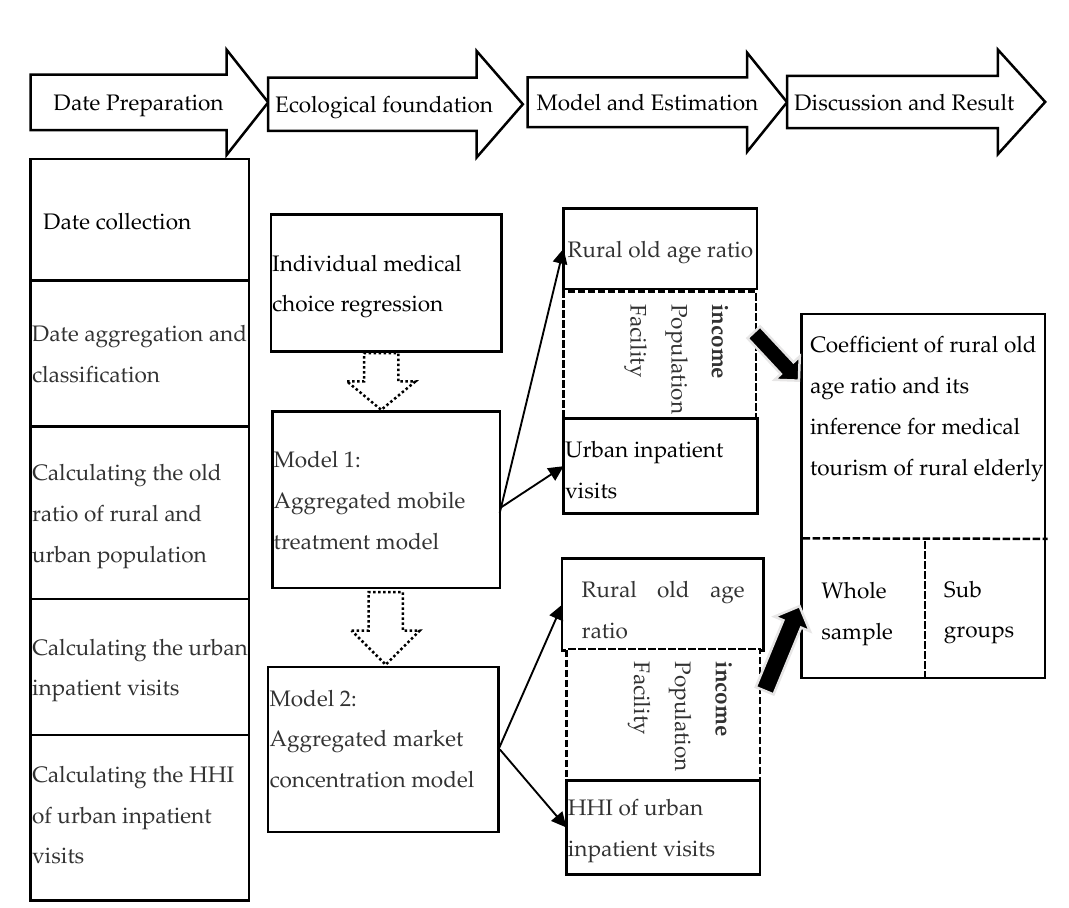
Figure 2. Conceptual scheme of the study design.